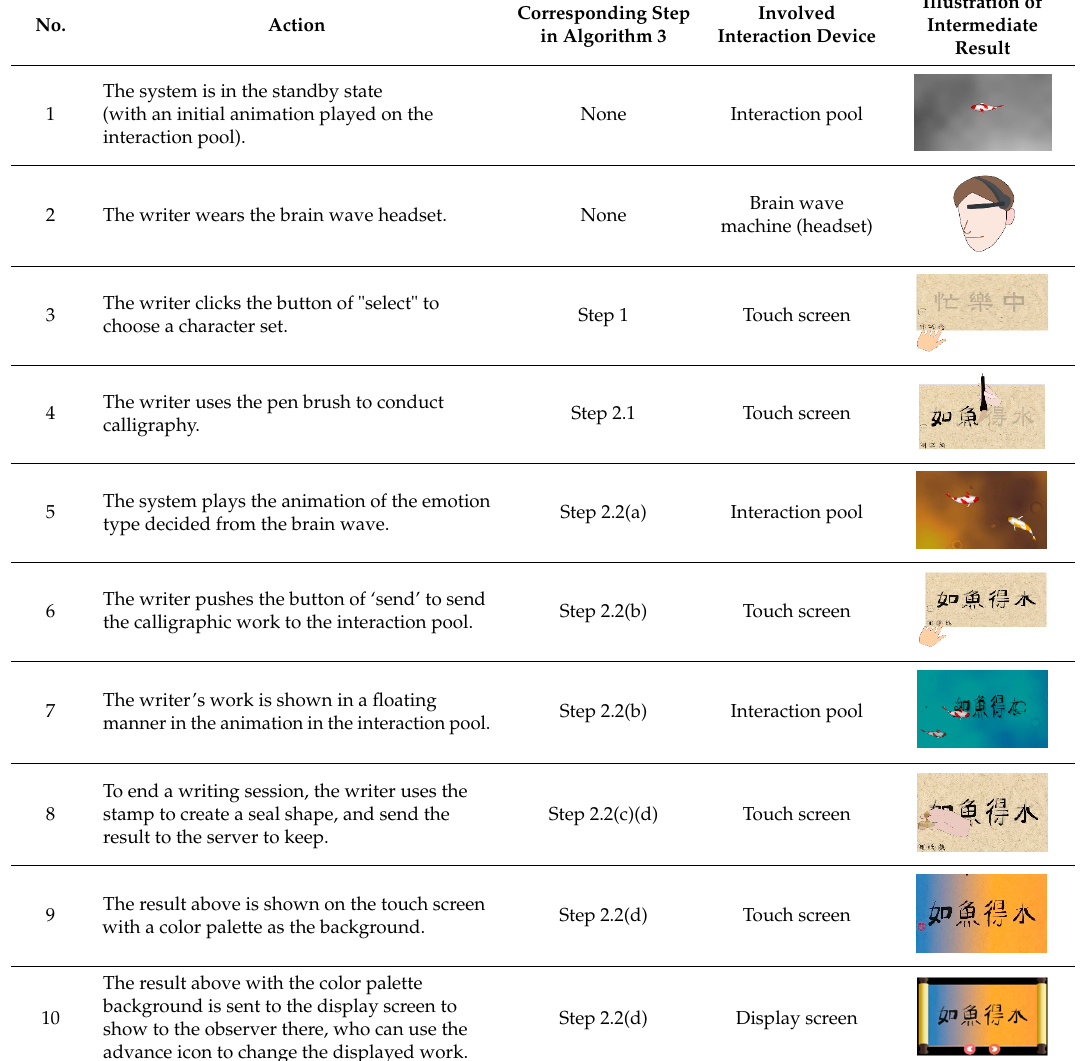
Table 5. List of items for observations of the two indicators of system usability and writer’s behavior.